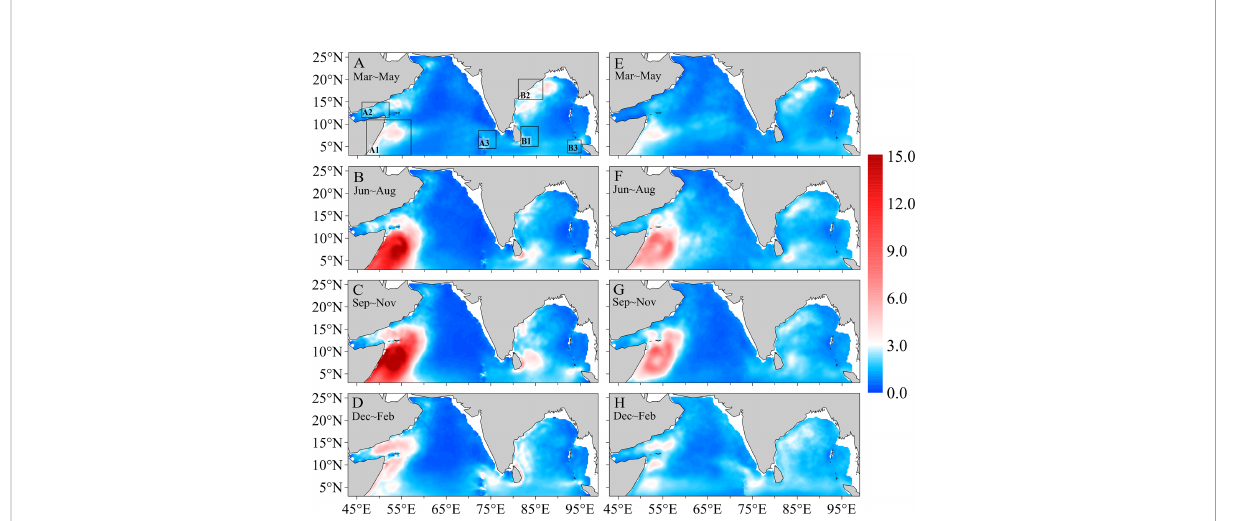
FIGURE 2 Seasonal distribution of eddy kinetic energy (EKE) (A-D) and eddy potential energy (EPE) (E-H) averaged from the surface to 200 m in spring (March – May), summer (June – August), autumn (September – November), and winter (December – February) (unit: 10 -2 m 2 ·s -2 ). The representative regions are marked as rectangles, including A1 (47° – 57°E, 3° – 11°N), A2 (46° – 52°E, 11.5° – 15°N), and A3 (72° – 76°E, 4.5° – 8.5°N) regions in the Arabian Sea and B1 (81.5° – 85.5°E, 5° – 9.5°N), B2 (81° – 86.5°E, 15.5° – 20°N), and B3 (92° – 95°E, 3.5° – 6.5°N) regions in the Bay of